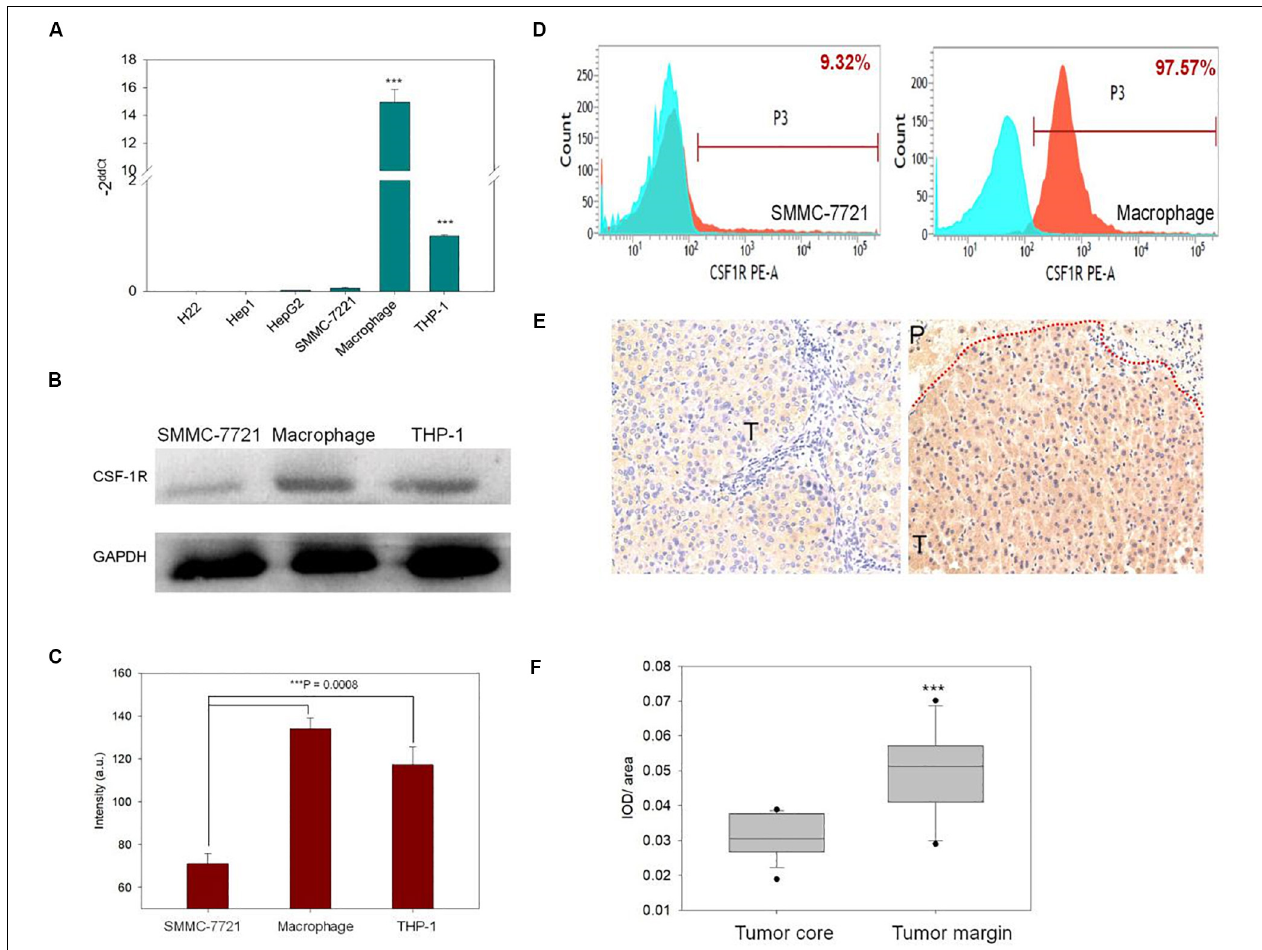
FIGURE 1 | (A) qRT-PCR was used to determine the expression of colony-stimulating factor 1 receptor (CSF-1R) in different cell lines. (B) Western blot was used to access the protein level of CSF-1R in macrophages, THP-1, and SMMC-7721. (C) Showed the CSF-1R expression intensity in macrophages, THP-1, and SMMC-7721, macrophages showed the highest intensity than THP-1 and SMMC-7721, (***indicates p < 0.01). (D) The expression level of CSF-1R in macrophages and SMMC-7721 were detected by fluorescence-activated cell sorting (FACS) blue indicated the control group and, red indiacted the experiment group. (E) IHC verified the expression distribution of CSF-1R in human liver cancer tissues (the red line indicated the boundary of hepatocellular carcinoma (HCC). (P, peritumoral, T, tumor). (F) Semi-quantitatively analyzed the expression of CSF-1R by image-pro plus (IPP) software (***indicates p < 0.01).